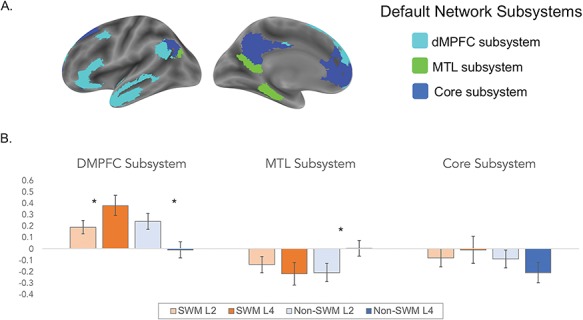
Neuroimaging results for the interaction contrast testing for activity associated with four-load (vs. two-load) SWM trials relative to four-load (vs. two-load) non-SWM trials. Panel A shows clusters in the dorsomedial subsystem of the default network (DMPFC, TPJ, MTG, TP, IFG). Panel B shows parameter estimates from each of these clusters for each condition.